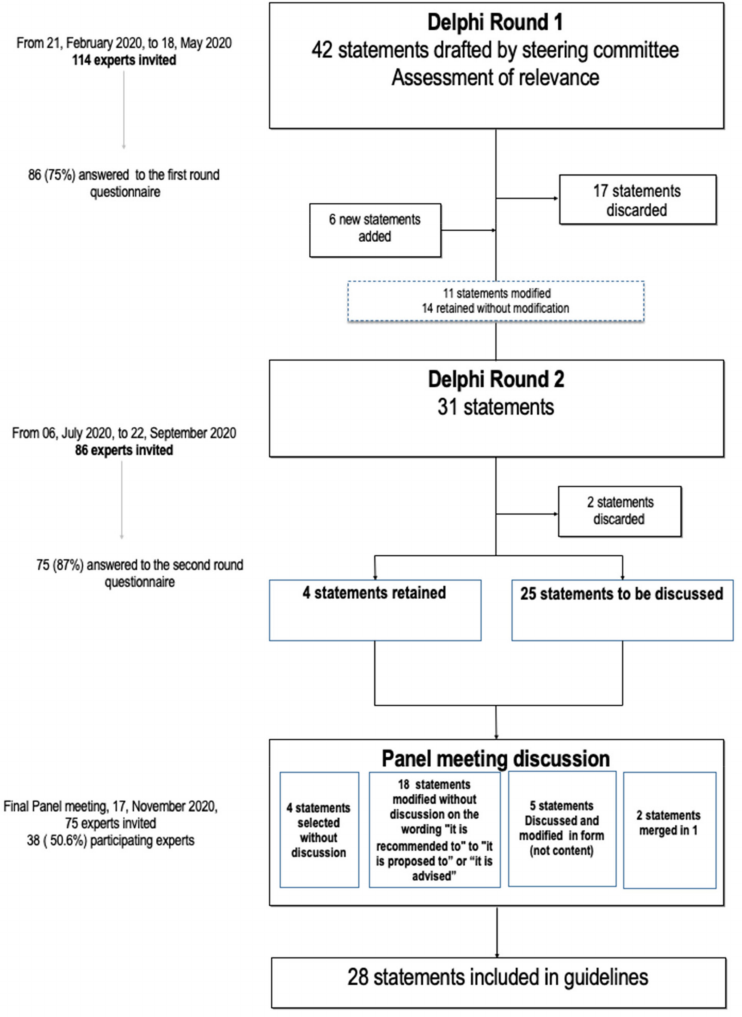
Figure 1. A stepwise two-round modified Delphi consensus survey to approve clinical guideline for fertility preservation in women with benign gynecologic